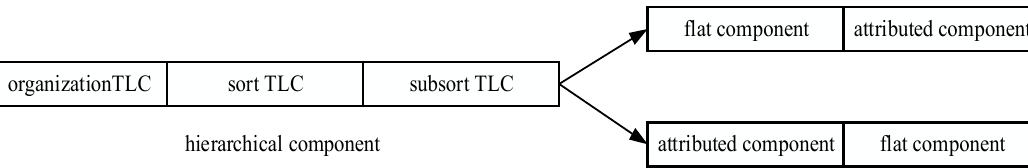
Figure 4. Mixed naming structure combination.